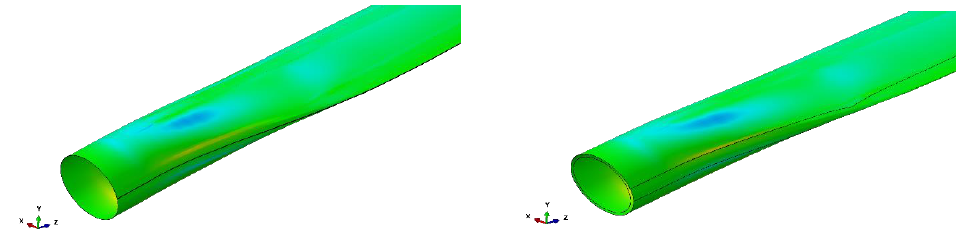
Figure 15. Contour plots of the transverse strain data for the negative flatwise load case. Transverse strains are observed next to the main girder. A very similar stress distribution is obtained by the shell and solid models. ( left ) OML shell model; ( right ) layered solid model.